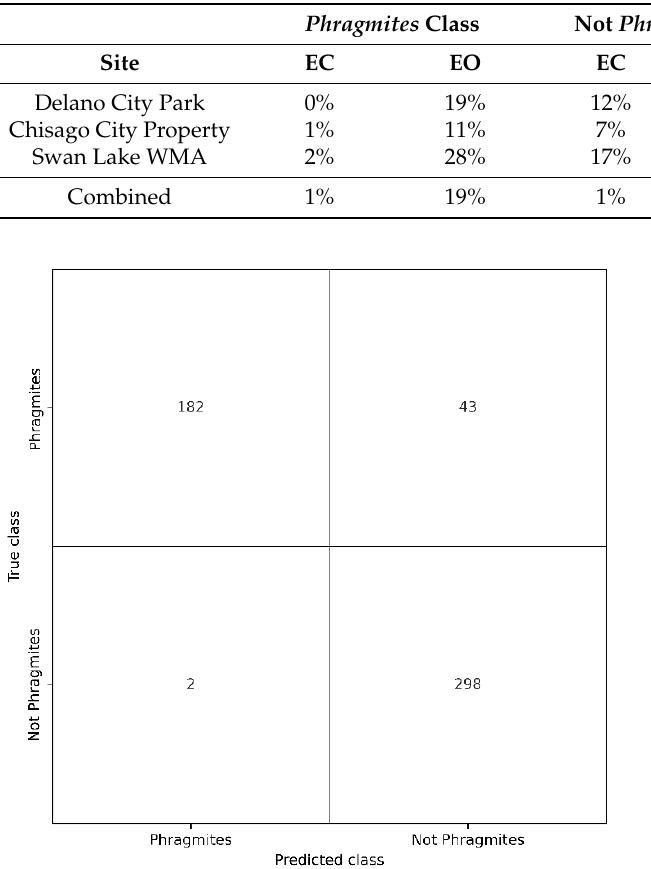
Table 17. Errors of commission (EC), errors of omission (EO), and Matthews correlation coefficient (MCC) values for the random forest classification with the post-ML OBIA rule set.